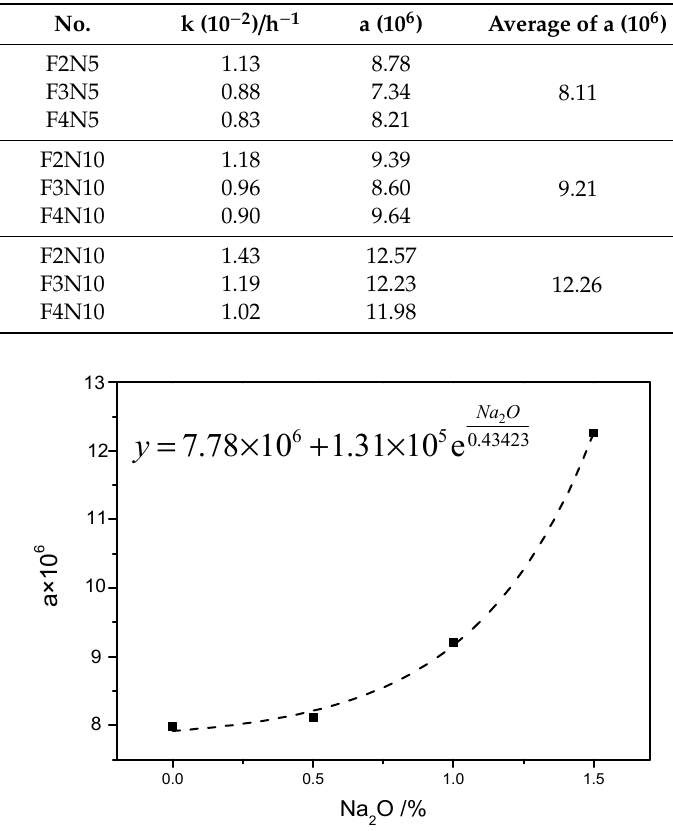
Figure 4. Relationship curve between values of a and dosages of Na 2 O.